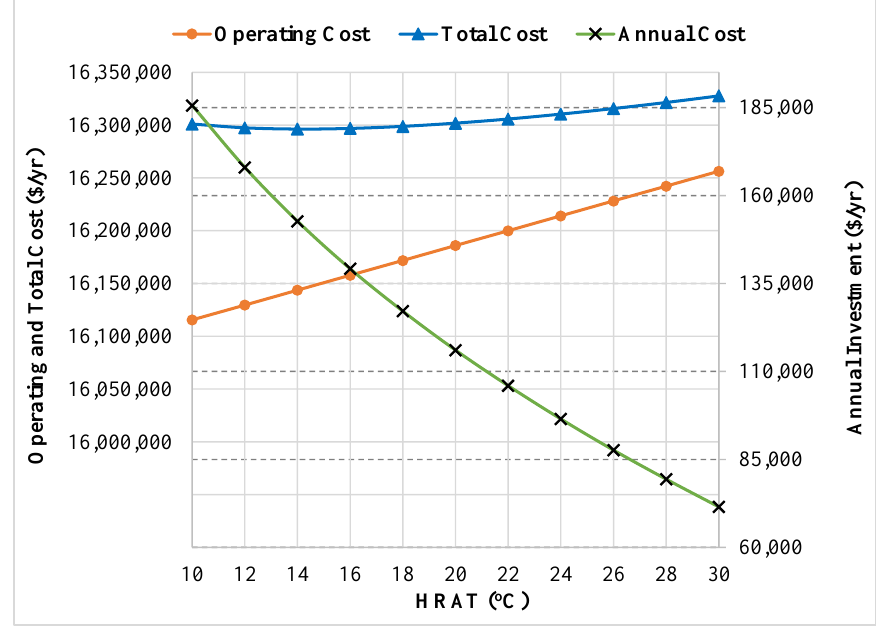
Figure 5. Economic profile of the optimized HEN using options (2) and (4).